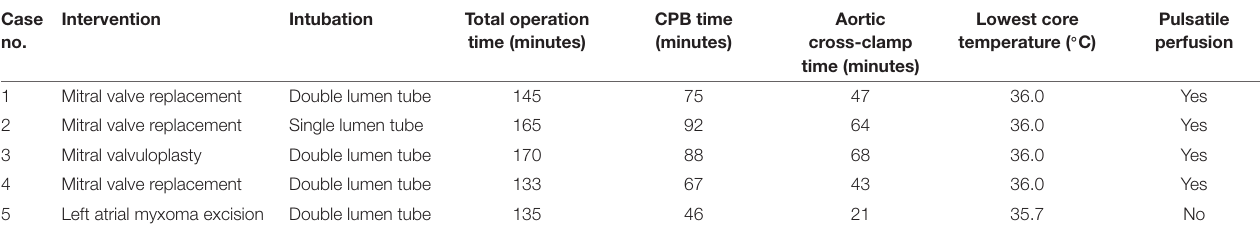
TABLE 2 | Intraoperative information of five patients undergoing MICS during pregnancy. Case no.